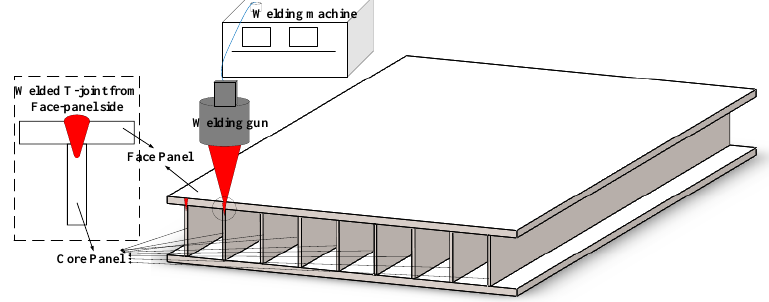
Figure 1. Welded T-joint from the face panel side in the web-core sandwich structure.